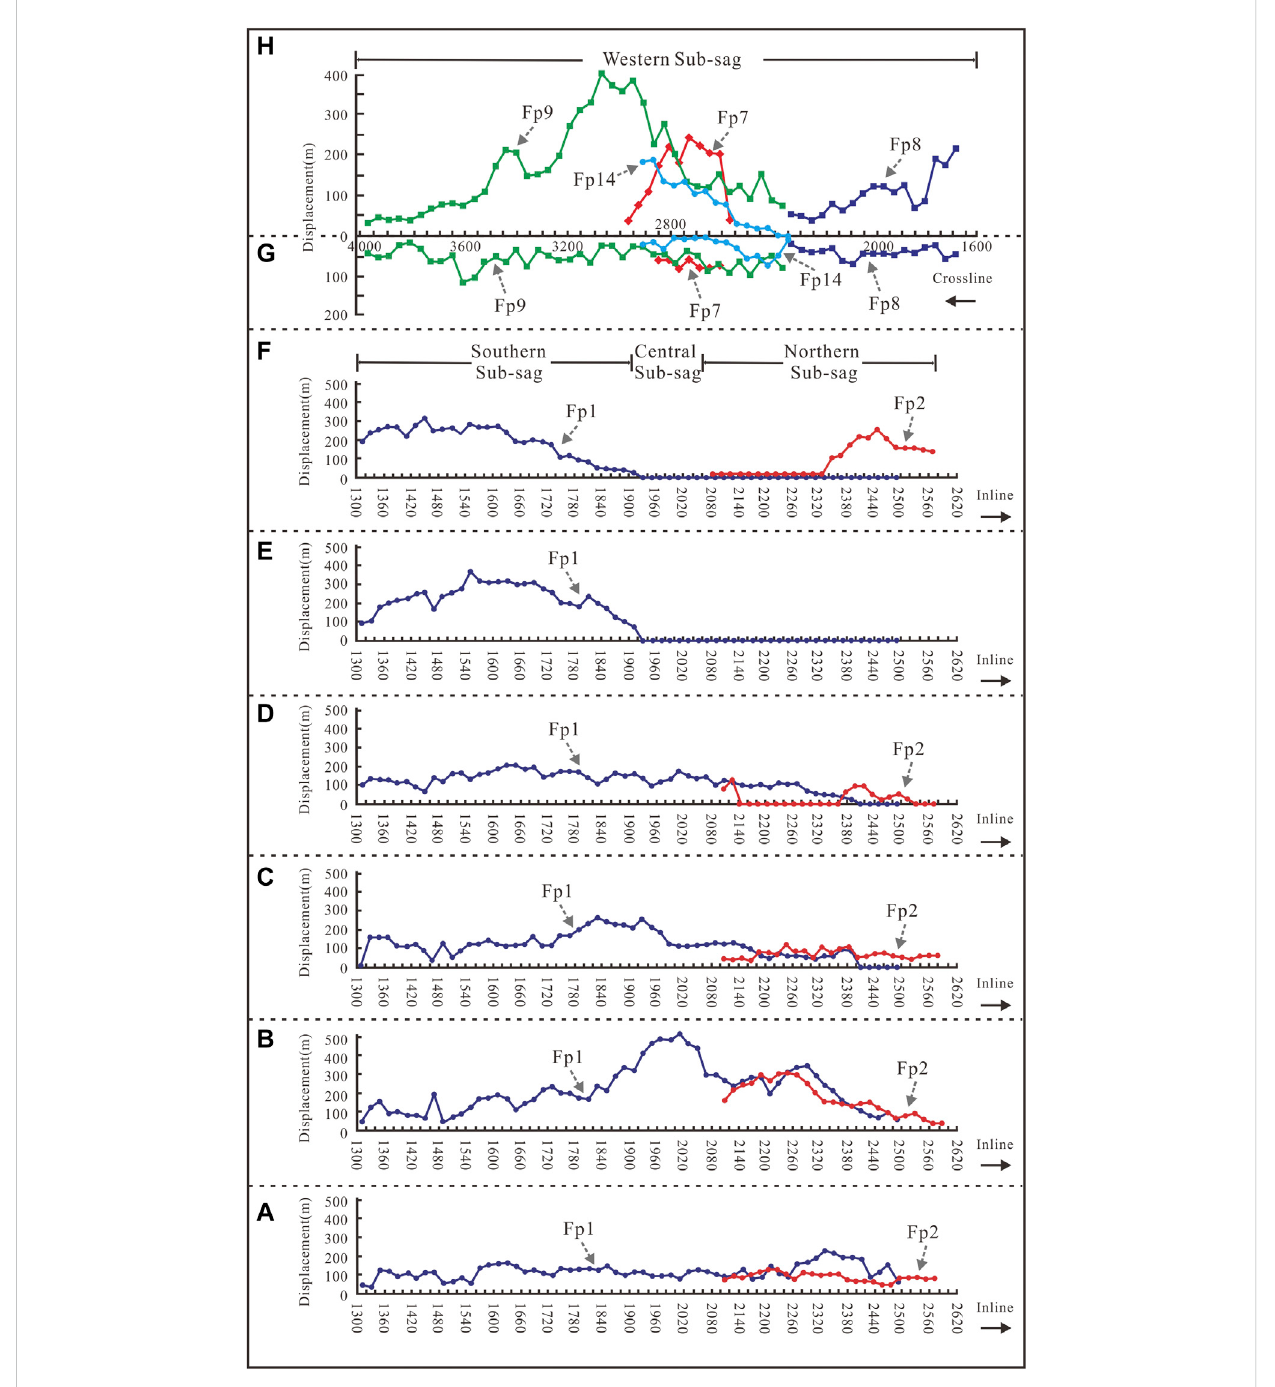
FIGURE 6 TheDisplacement-distancecurvesofmaincontrollingfaults(Fp1,Fp2,Fp7,Fp8,Fp9,Fp14)inthePanyu4Sag.TheDisplacement-distancecurvesof Fp1 and Fp2 during the RP1 (A – E) and RP2 (F) ; The Displacement-distance curves of Fp7, Fp8, Fp9 and Fp14 during the RP1 (G) and RP2 (H)